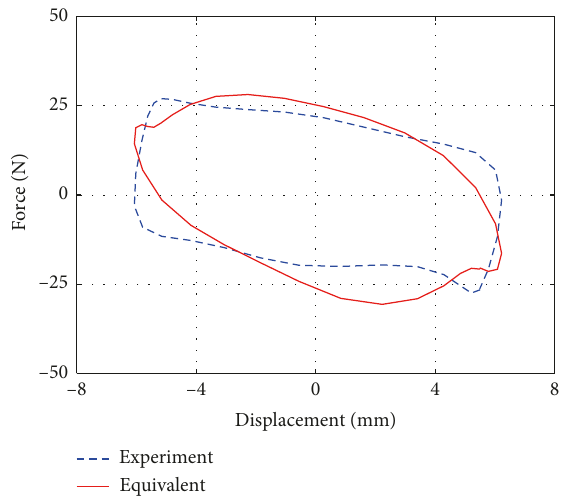
Figure 3: Equivalent hysteretic loops for the experimental NSD.